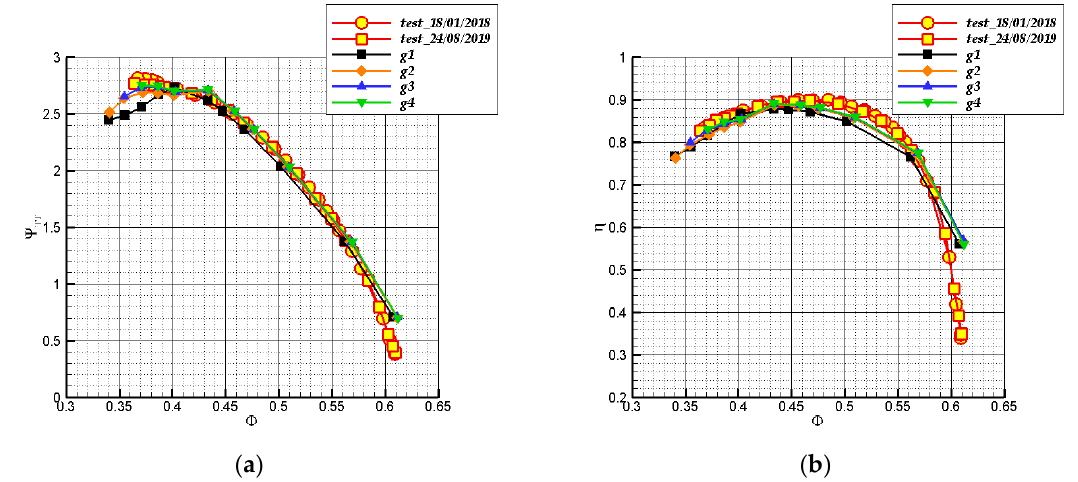
Figure 10. The numerical results and test data. ( a ) Pressure rise characteristic; ( b ) total to total isentropic e ffi ciency